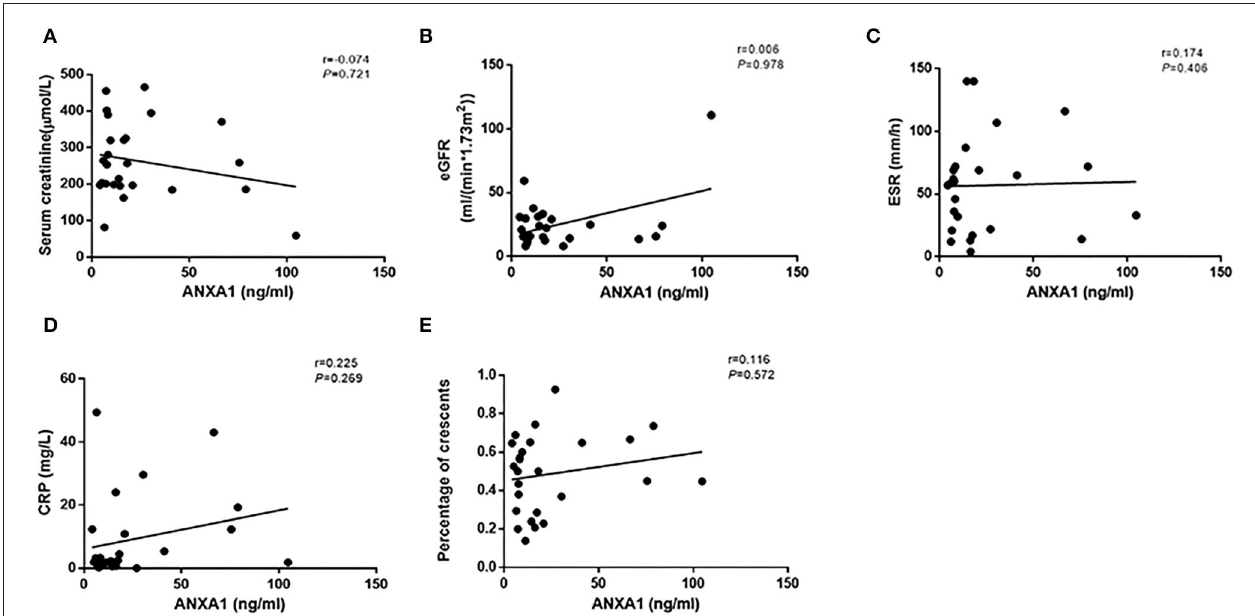
FIGURE 2 | Correlation analyses of ANXA1 levels in plasma of active AAV patients and serum creatinine (A) , eGFR (B) , ESR (C) , CRP (D) and the proportion of crescents (E) , respectively. ANXA1, annexin A1; eGFR, estimated glomerular filtration rate; ESR, erythrocyte sedimentation rate; CRP, C-reactive